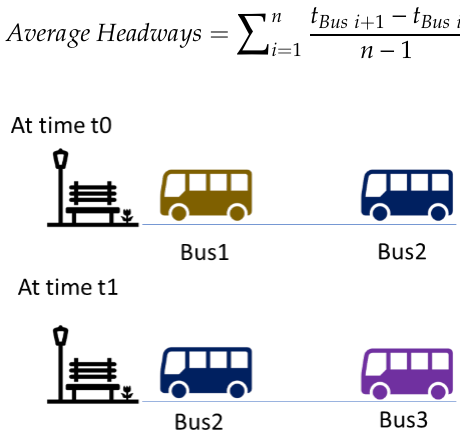
Figure 11. Bus arrival at a bus stop for different time instances.